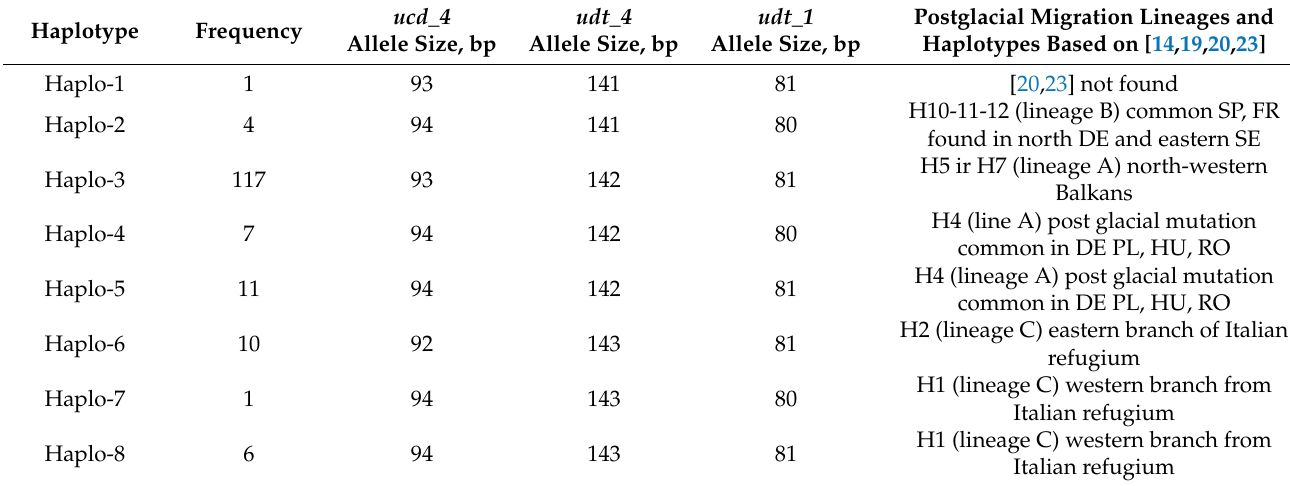
Table 4. The haplotype frequencies and descriptions. The allele sizes are given as found in our study. Frequency is the number of trees carrying a particular haplotype.